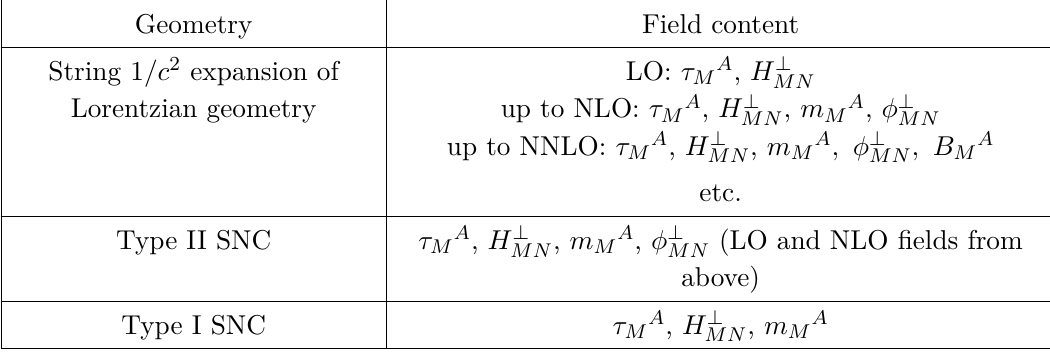
Table 1 . Overview of geometries of SNC type and how they arise from the string 1 /c 2 expansion of Lorentzian geometry. All of these may be subjected to foliation constraints: the most general such constraint is that τ A defines a co-dimensions- 2 foliation, i.e., dτ A = α A B ∧ τ B for arbitrary 1 -forms α A B . Important special cases include α A A = 0 and α A B = ε A B ω for some 1 -form ω . The latter is known as the strong foliation constraint. When the strong foliation constraint holds the gauge transformations of τ MA , H ⊥ , m MA for type II SNC agree with those of type I MN